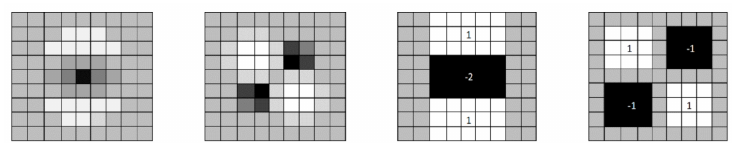
Figure 8. Left to right: The 9 × 9 box (discretized and cropped) Gaussian second order partial derivatives in y -direction. The grey regions are equal to zero.